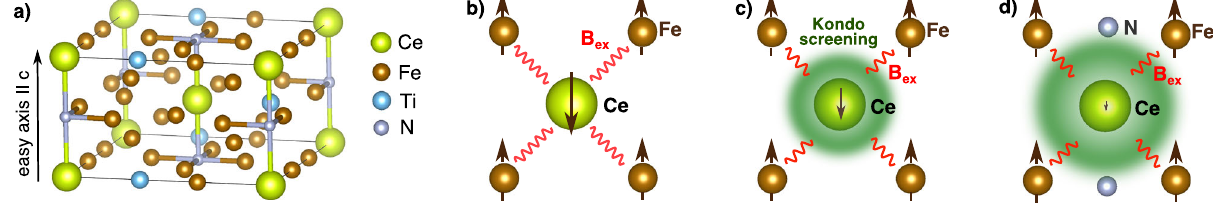
Fig. 1 Crystal structure, Ce magnetism, and Kondo effect in Ce – Fe “ 1 – 12 ” . a Tetragonal body-centered crystal structure of CeFe 11 TiN (space group I4/ mmm ). b Quasi-atomic approximation to the Ce magnetism. The Ce-4 f spins are aligned antiparallel with respect to the Fe moments due to the exchange fi eld B ex . The magnitude of the Ce magnetic moment in this quasi-atomic picture is determined by B ex and the crystal fi eld splitting on the Ce-4 f shell. c Many-electron effects drastically alter this picture: the Kondo screening (green cloud) reduces the Ce magnetic moment concomitantly lowering the Ce contribution to the magnetic anisotropy. d The Kondo effect is strongly sensitive to the local environment: it is dramatically enhanced by nitrogen interstitials thus almost completely suppressing the Ce-4 f contribution to the magnetic anisotropy.